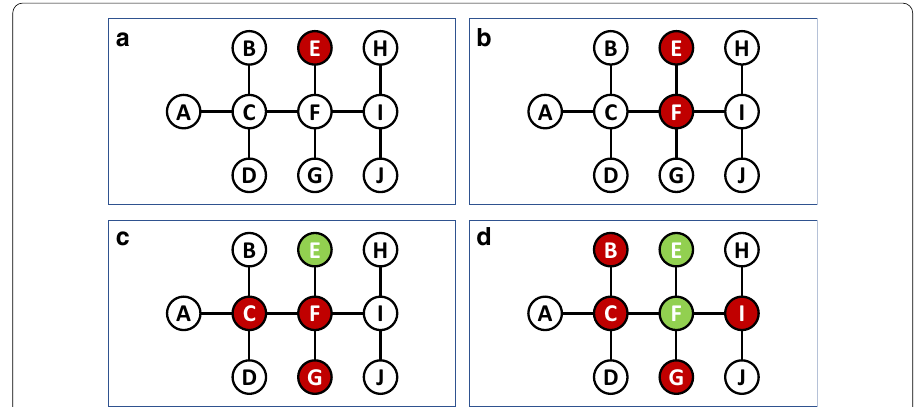
Fig. 2 Four consecutive snapshots of the SIR contagion process over the network from Fig. 1. Susceptible nodes ( S ) are marked in white, infected nodes ( I ) are marked in red, and recovered nodes ( R ) are marked in